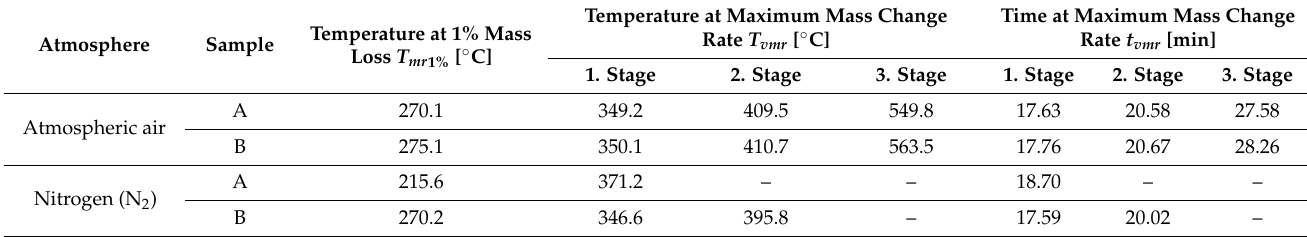
Table 1. Thermogravimetric analysis